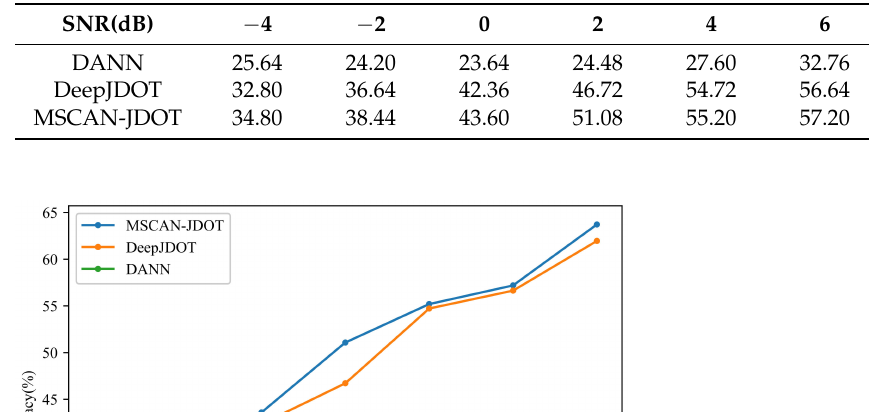
Table 5. A-C transfer accuracy in noisy environment (%).